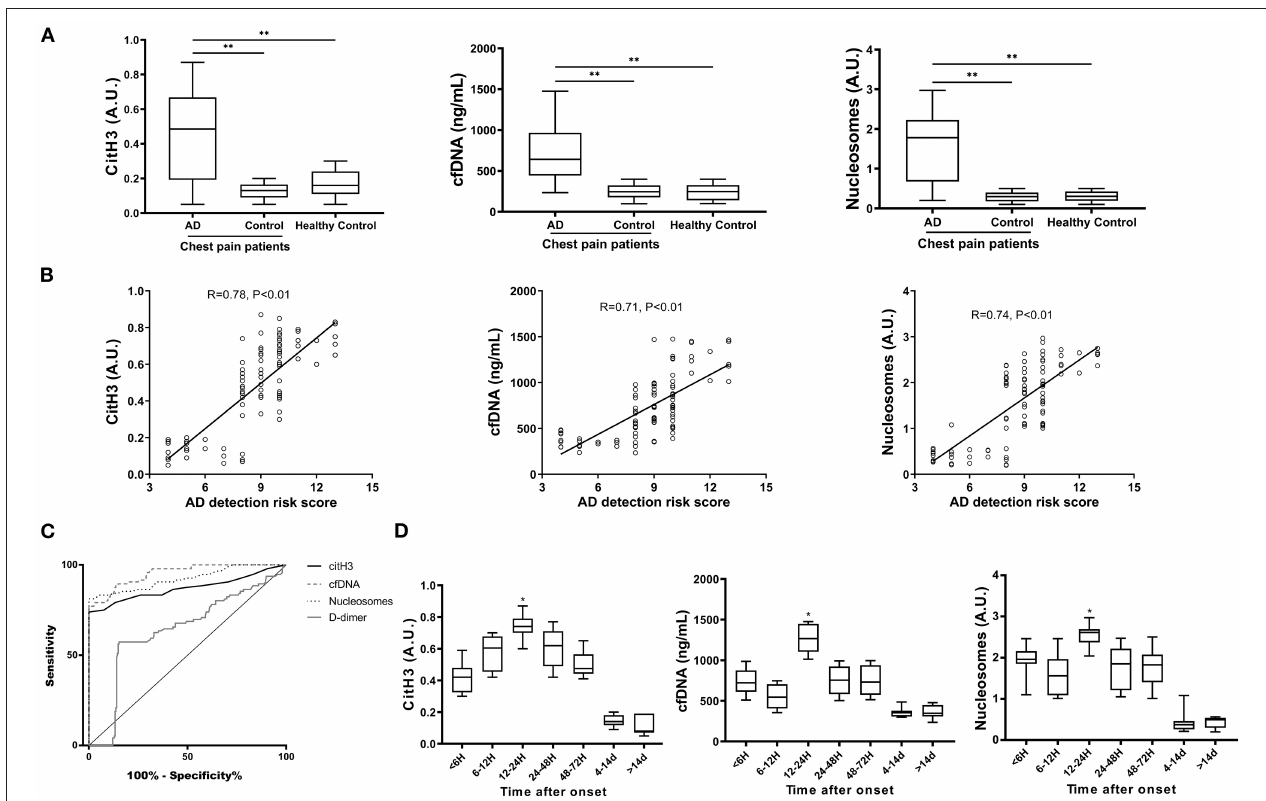
FIGURE 1 | The diagnostic performance of circulating NET markers for discriminating AAD. (A) Serum levels of citrullinated H3 (citH3), cell-free DNA (cfDNA), and nucleosomes were evaluated in 96 patients with AAD and 249 patients in the control group. CitH3 and nucleosomes are expressed in arbitrary units (AU). The cfDNA concentration (ng/mL) was determined based on a calibration curve of calf thymus DNA. All three markers were significantly higher in the AAD group than in the control group. (B) Serum levels of citH3, cfDNA and nucleosomes were positively correlated with the detection risk score of AD. (C) ROC curve for the diagnosis of AAD. Circulating NET markers showed superior overall diagnostic performance compared with D-dimer when sudden-onset chest pain was present in the emergency department. (D) The time course of NET markers was examined in patients with AAD according to the admission time from symptom onset. The peak NET marker levels occurred within 12–24h of symptom onset. * P < 0.05, ** P <